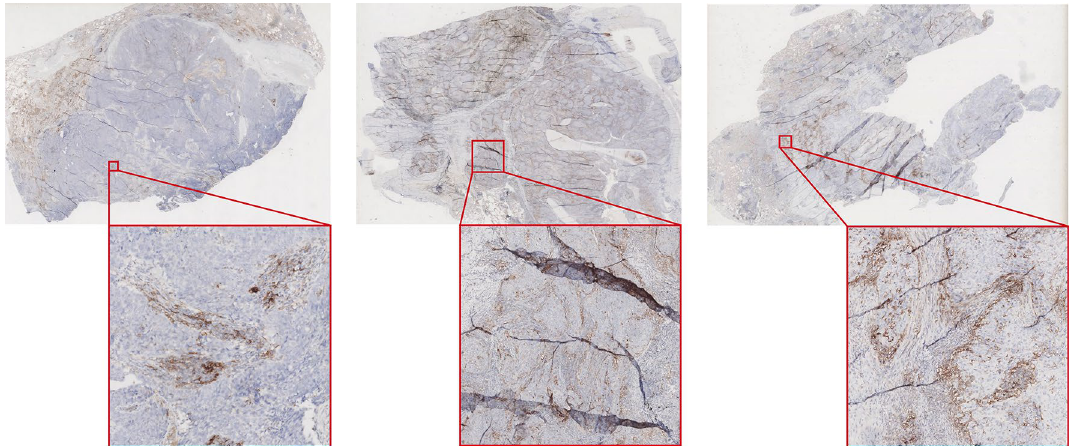
Figure 5. Three PD-L1 negative expression slides mis-classified as weak expression. These slides have different levels of tissue-fold, non-specific staining, and intermixing of tumor and non-tumor